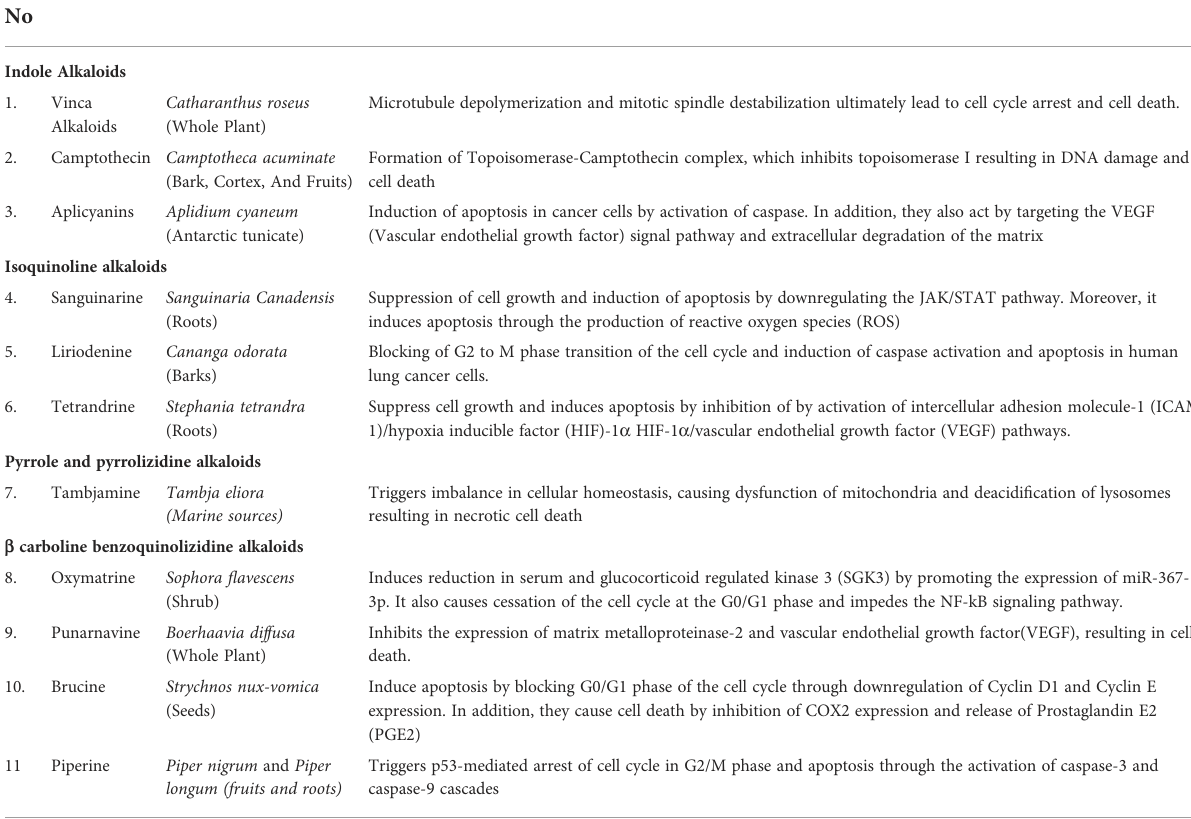
TABLE 1 Mechanisms of action of some prominent alkaloids in the treatment of lung